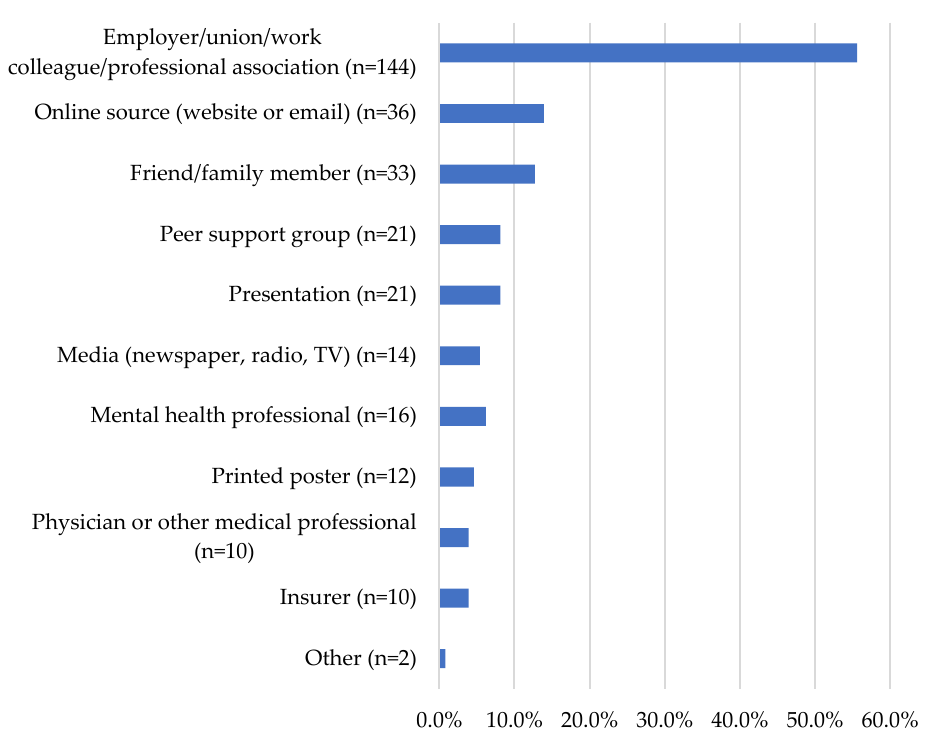
Figure 2. How did prospective clients first hear about PSPNET?